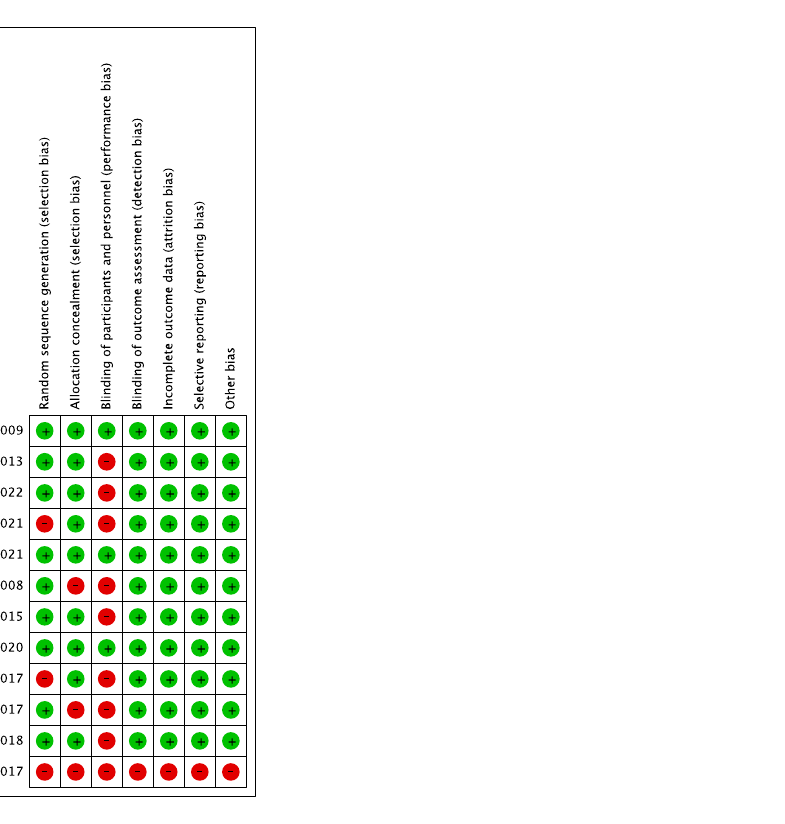
Figure 2. Risk of bias assessment. Red (-) indicates high risk and green (+) low risk in the studies included